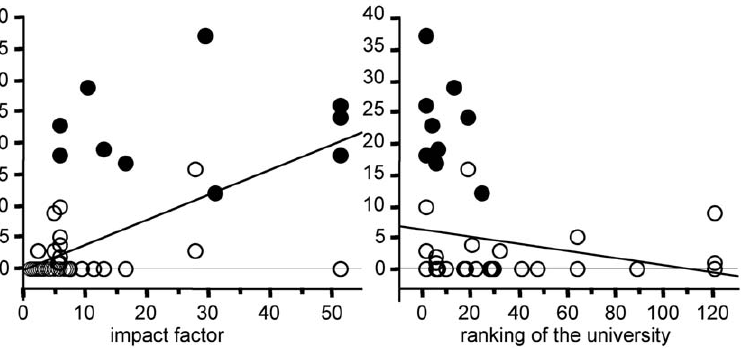
Figure 6. Newspaper coverage of ‘‘top 10’’ publications and of their 67 related scientific studies. The number of newspaper articles reporting on each scientific study is expressed as a function of either the impact factor of the scientific journal publishing the scientific study (left), or the ranking of the university in which the study was performed (right). The relationship with the impact factor (R 2 =0.33 ANOVA: f=36.8 p , 0.0001) and with the university ranking (R 2 =0.10 ANOVA: f=8.4 p=0.005) are statistically significant. The ‘‘top10’’ publications are indicated by filled circles.